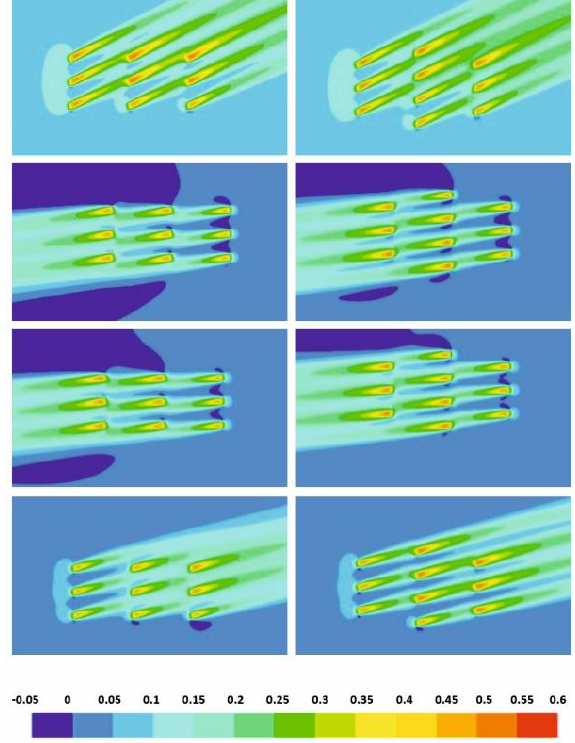
Figure 8. Isocontour of velocity deficit in the case with incidence (RWI) in a tidal farm with an aligned (left) and a staggered layout (right) for time 1.22 h (R1), 4 h, 6.22 h (R2), and 12.25 h (R1).